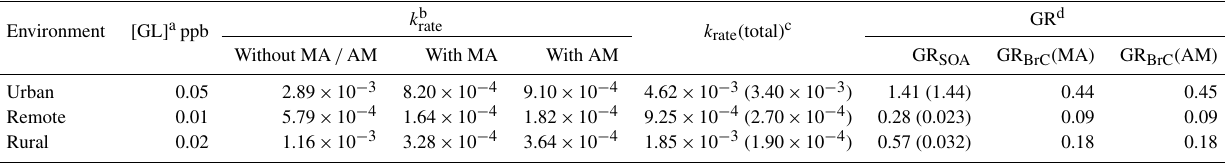
Table 1. Estimation of the rates for the oligomerization without and with MA / AM and the growth rates to SOA and BrC under different atmospheric conditions.